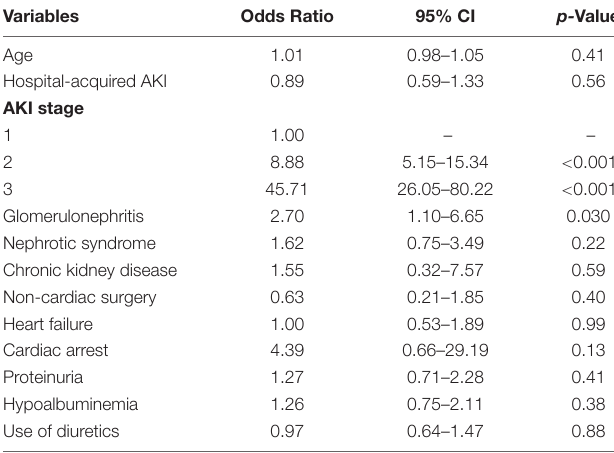
TABLE 5 | Multivariable logistic analysis for predictors of AKD stage